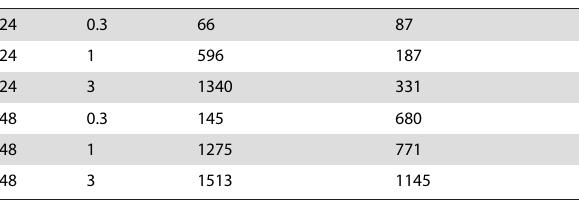
U133A 2.0 gene chipset. The table shows the number of genes regulated by AZA and DAC at different drug concentrations. Duplicate samples of each were averaged and compared with untreated samples. A fold change of $ 1.7 in gene expression was considered as regulated. AZA = azacitidine; DAC = decitabine.